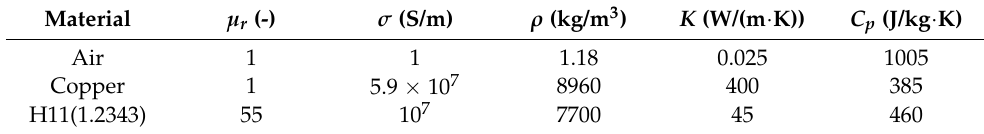
Table 2. Material